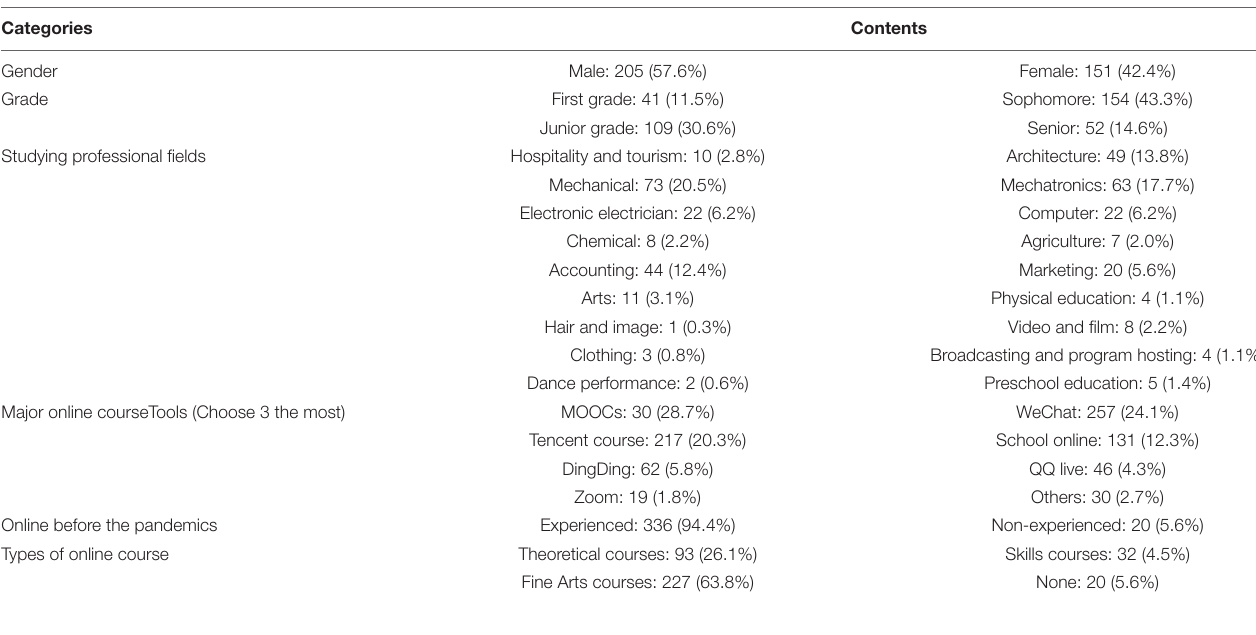
TABLE 1 | Background information of